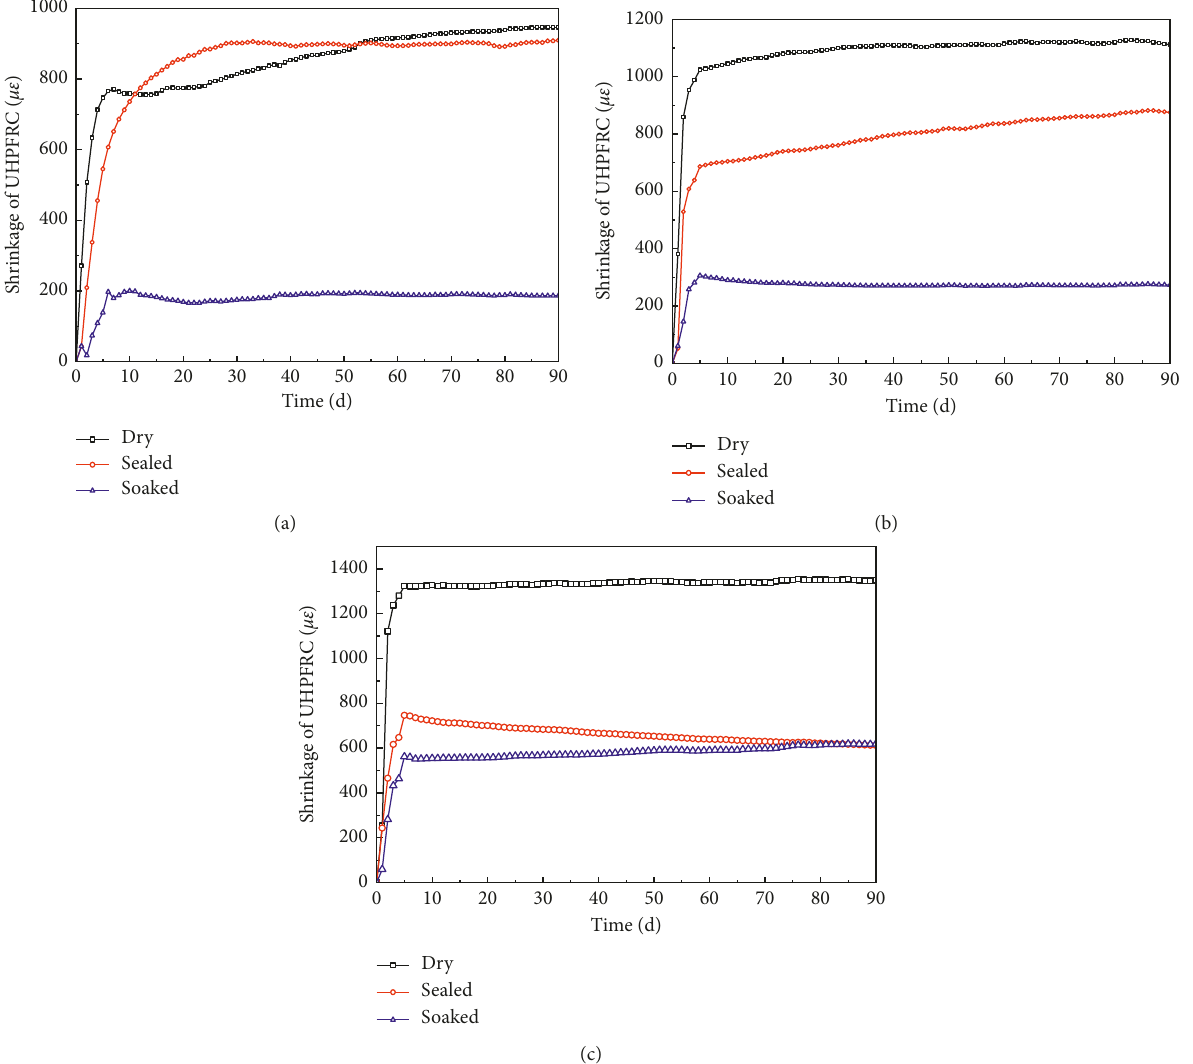
Figure 5: The shrinkage curve of UHPFRC in different temperature curing conditions in 90d. (a) 25 ° C. (b) 40 ° C. (c) 75 °